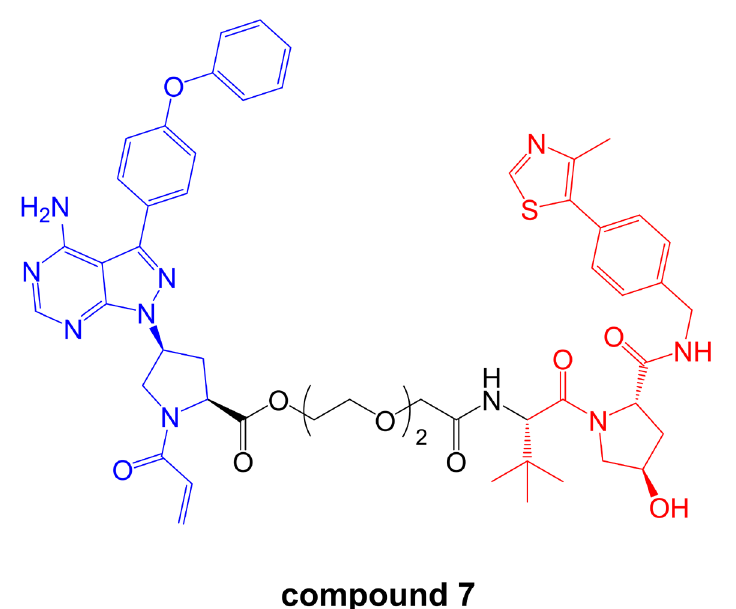
Figure 9. Structure of covalent PROTAC compound 7. BTK-inhibiting warhead related to ibrutinib is colored blue and VHL-targeting moiety is colored red